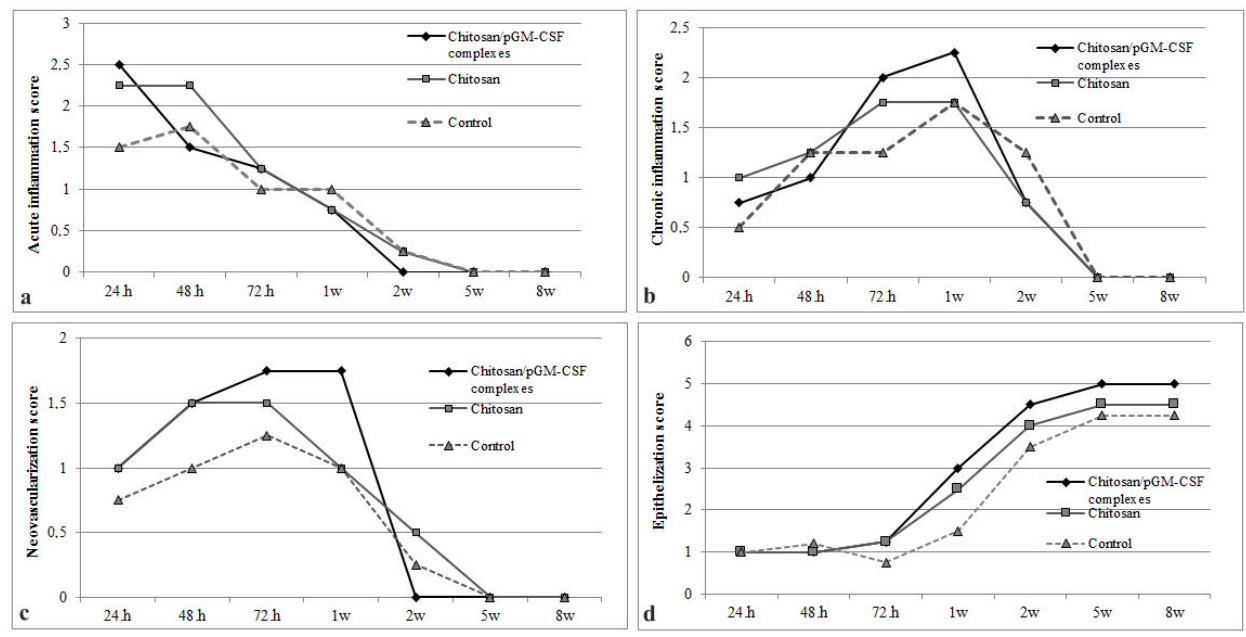
FIGURE 7 - Changes in (a-b) acute and chronic inflammation scores, (c) neovascularization score, (d) epithelization score depending on